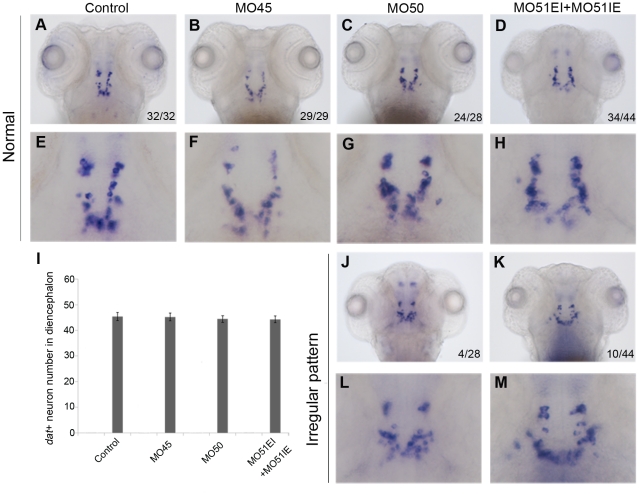
RNA whole mount in situ hybridization of 3 dpf embryos with dat probe didn't show significant loss of DA neurons in morphant.E to H, L and M, enlargement of the area of DA neurons in A to D, J, and K, respectively. The numbers on bottom right corner showed number of the embryos with a certain phenotype/number of total embryos in that group. The patterns of DA neurons in most embryos were normal, while some were disorganized. I, the quantitative result of dat positive neurons in the diencephalon. There is no significant DA neuron loss in morphant group. n = 20 in each group, P>>0.05 in all comparisons.